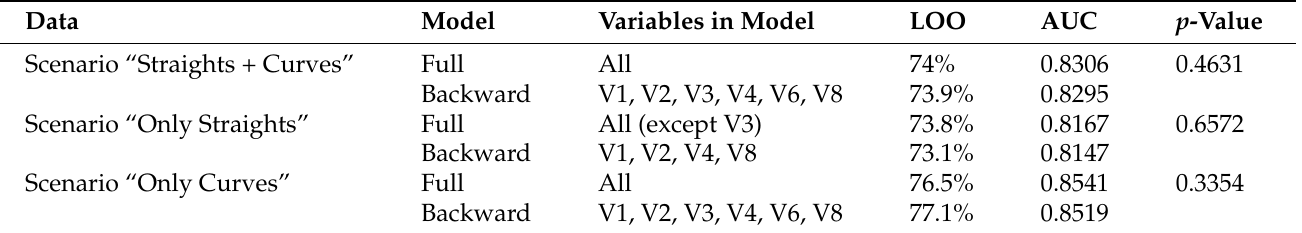
Table 3. Model selection for the three scenarios (results from Backward and Forward selection model were the same).